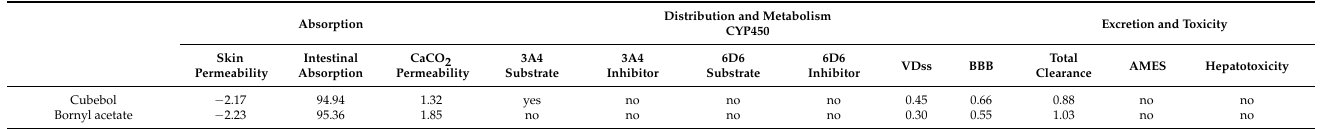
Table 7. Pharmacokinetic (ADMET) properties of cubebol and bornyl acetate compounds.